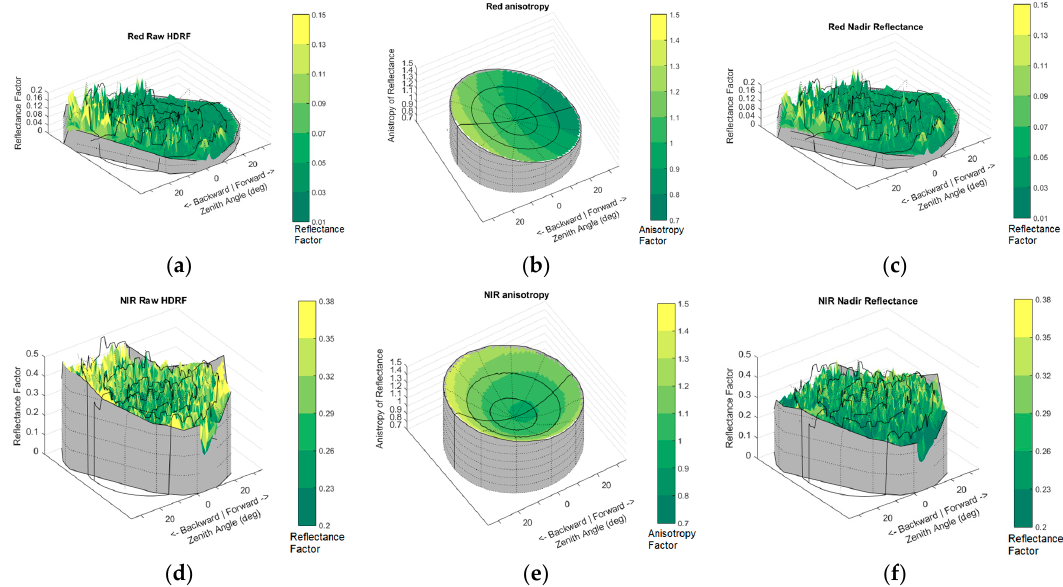
Figure 12. Hemispherical directional reflectance factor (HDRF) plots created using the flight f34 data. ( a ) Raw HDRF observations; ( b ) anisotropy model and ( c ) BRDF corrected reflectance factors of green band; ( d ) Raw HDRF observations; ( e ) anisotropy model and ( f ) BRDF corrected reflectance factors of NIR band. In ( b , e ) the model is based on block adjustment.